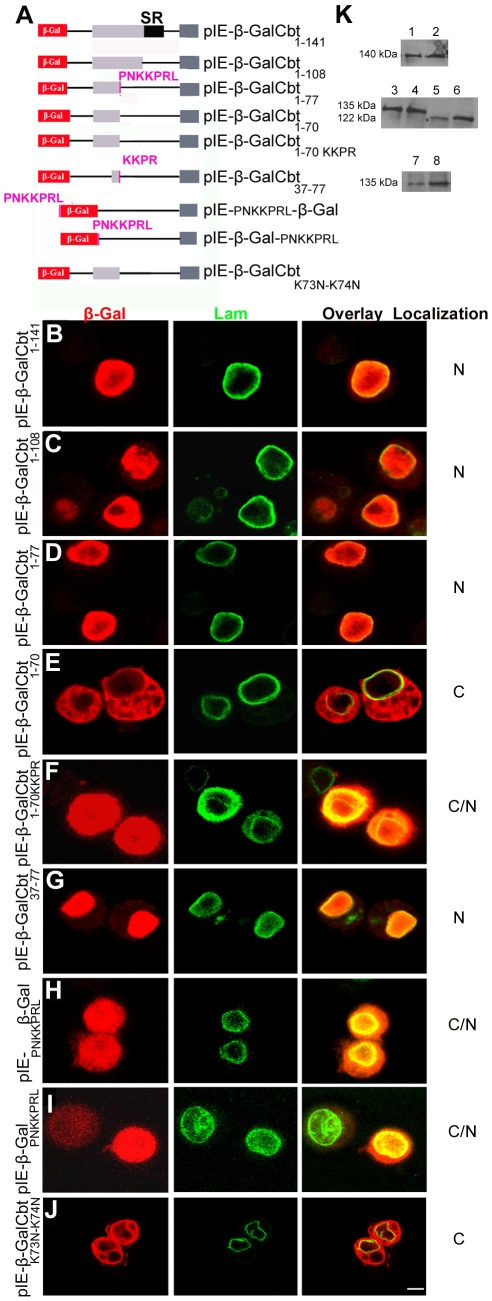
The 71PNKKPRL77 sequence is the NLS of the Cabut protein.(A) Schematic representation of the β-GalCbt fusion constructs transfected into S2 cells to determine whether the 162KMNRKRAAEVALPPVQTPETPVAKLVTPP190 and/or 71PNKKPRL77 sequences are functional NLSs. The Serine-rich (SR) domain is shown in black and the PNKKPRL sequence in fuchsia. (B–J) Localization of β-Gal fusion proteins in S2 cells transiently transfected with the constructs shown in (A). Cells were stained with anti-β-Gal (red; first panel) and anti-Lam (green; second panel) to mark nuclear membranes. The overlay panel depicts double staining of cells with both antibodies, and the localization of the fusion proteins is shown in the fourth panel (C, cytoplasmic; N, nuclear). Note that fusion proteins lacking or containing a mutated 71PNKKPRL77 sequence (E and J) were cytoplasmic. The 71PNKKPRL77 sequence was able to translocate β-Gal to the nucleus when fused to either the N- or the C-terminus of the protein (H and I). Scale bar: 10 µm. (K) Western blots of protein extracts from S2 cells transfected with the constructs shown in (A) and stained with anti-β-Gal. (1) pIE-β-GalCbt1–141 (∼140 kDa), (2) pIE-β-GalCbt1–108 (∼140 kDa), (3) and (7) pIE-β-GalCbt1–77 (∼135 kDa), (4) pIE-β-GalCbt1–70 (∼135 kDa), (5) pIE-PNKKPRL-β-Gal (∼120 kDa), (6) pIE-β-Gal-PNKKPRL (∼120 kDa) and (8) pIE-β-Gal-CbtK73N–K74N (∼135 kDa).